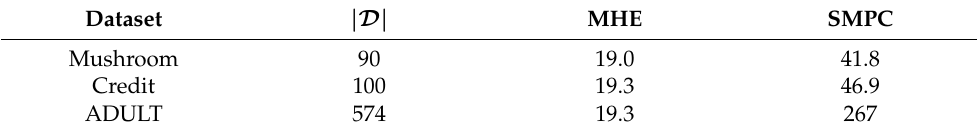
Table 9. Runtime (s) of running the secure federated χ 2 -test on various datasets.